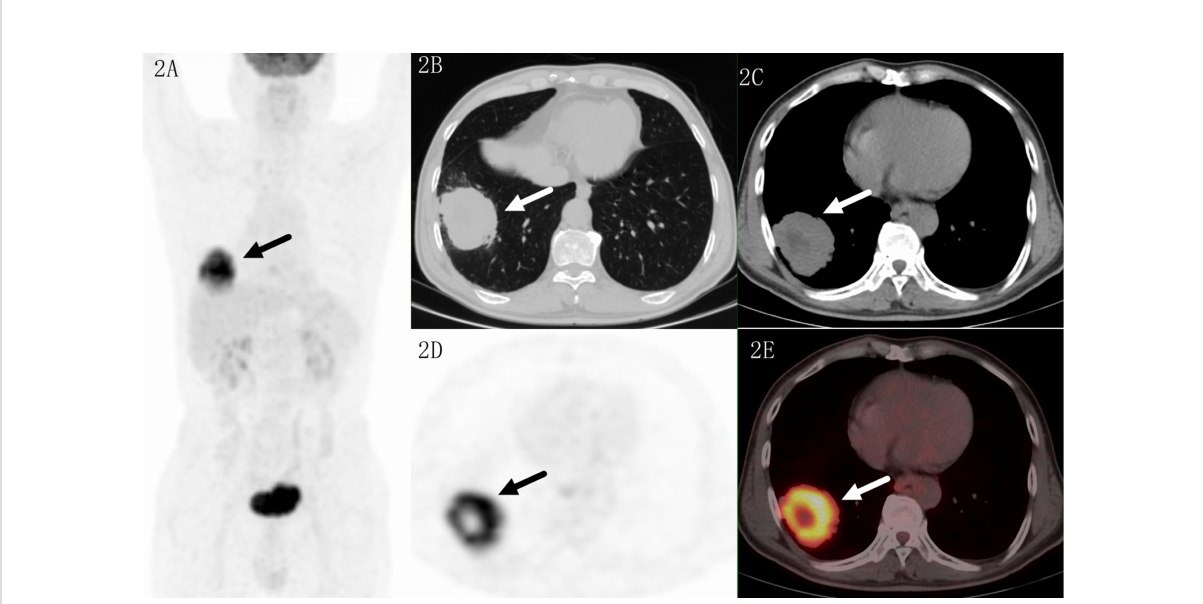
FIGURE 2 Images of a 69-year-old male patient with adenocarcinoma. PET MIP (A) showed a mass in the right lower lobe and a suspected lymph nodes in the right hilar. The lesion located in sub pleural site with a SUVmax of 16.4 on transaxial CT (B, C) , PET (D) and fused (E) images. Higher uptake was seen in the proximal region which indicated malignant